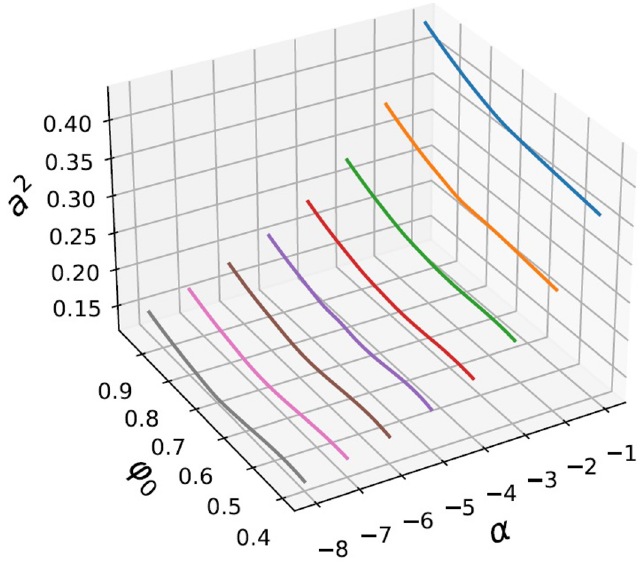
Figure 8 . The squashing parameter a 2 as a function of the two parameters, ϕ 0 and α , for Nut end-point solutions.